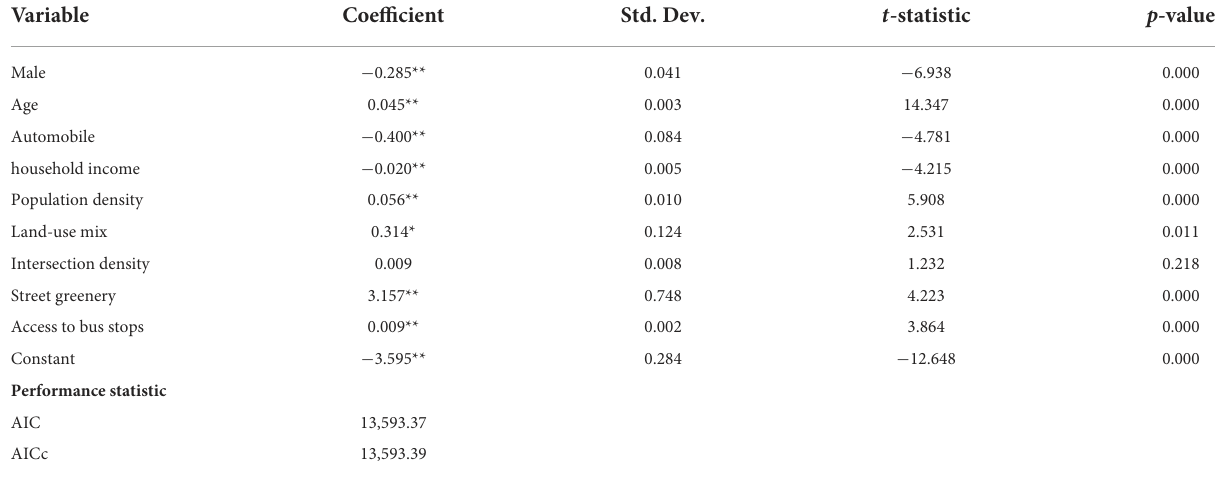
TABLE 2 Global modeling results.